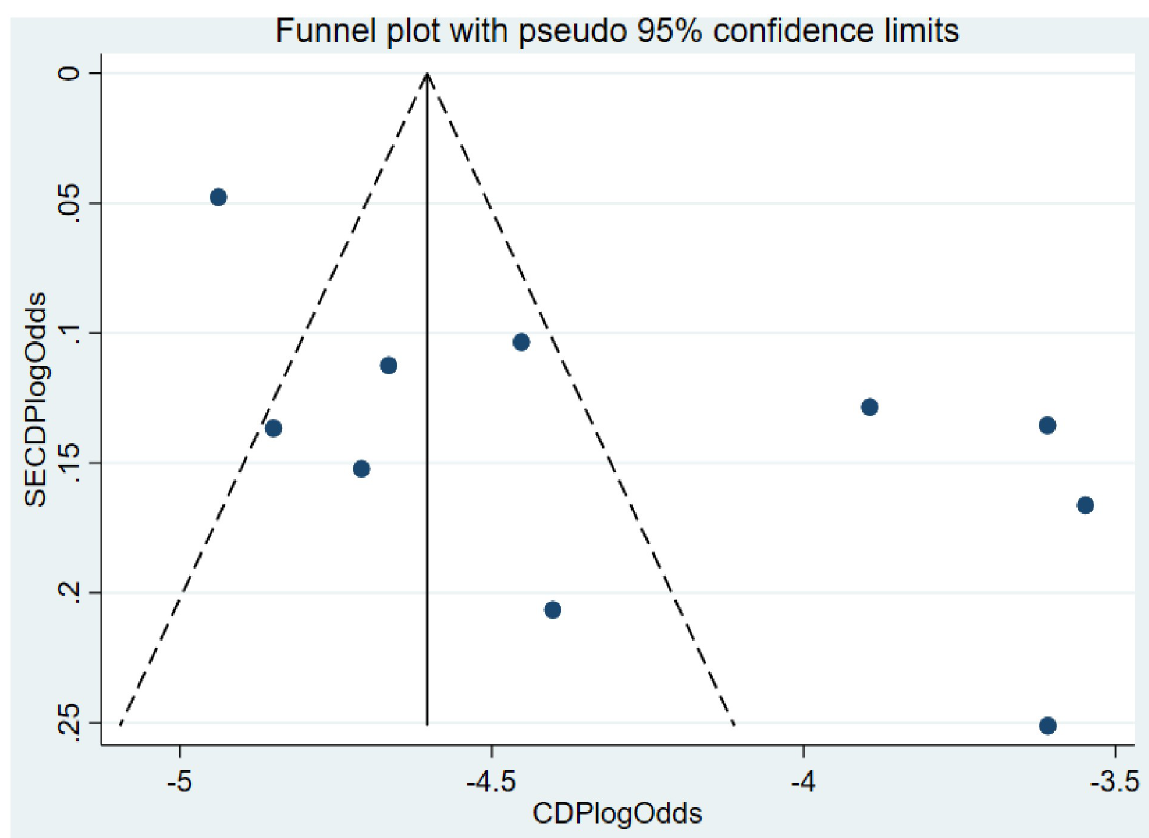
Fig 3. Funnel plot test for publication bias for the pooled prevalence of C . difficile among hospitalized diarrheal patients.